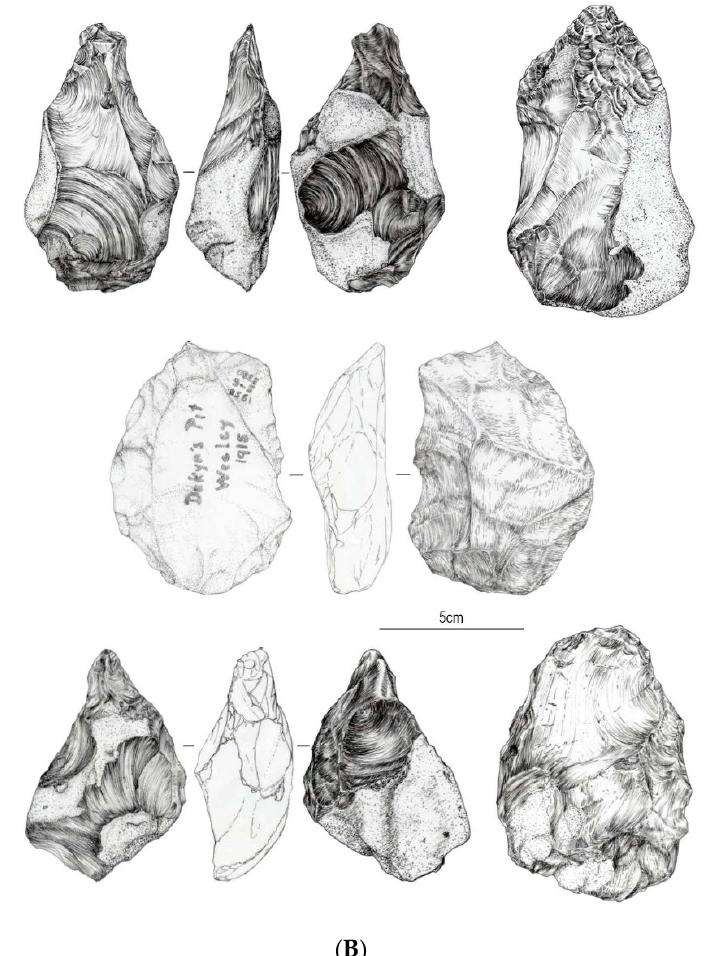
Figure 6. Artefacts from Daking’s Pit, Warren Collection, British Museum. ( A ) Photographs and ( B ) drawings (next page) by Ellen-May Littlewood.